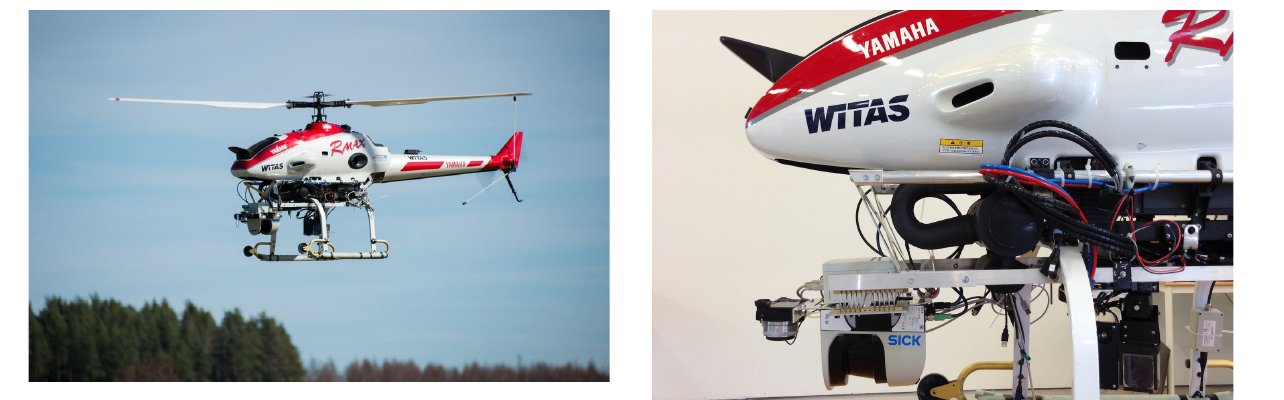
Figure 1: The UAS Tech Lab RMAX helicopter.